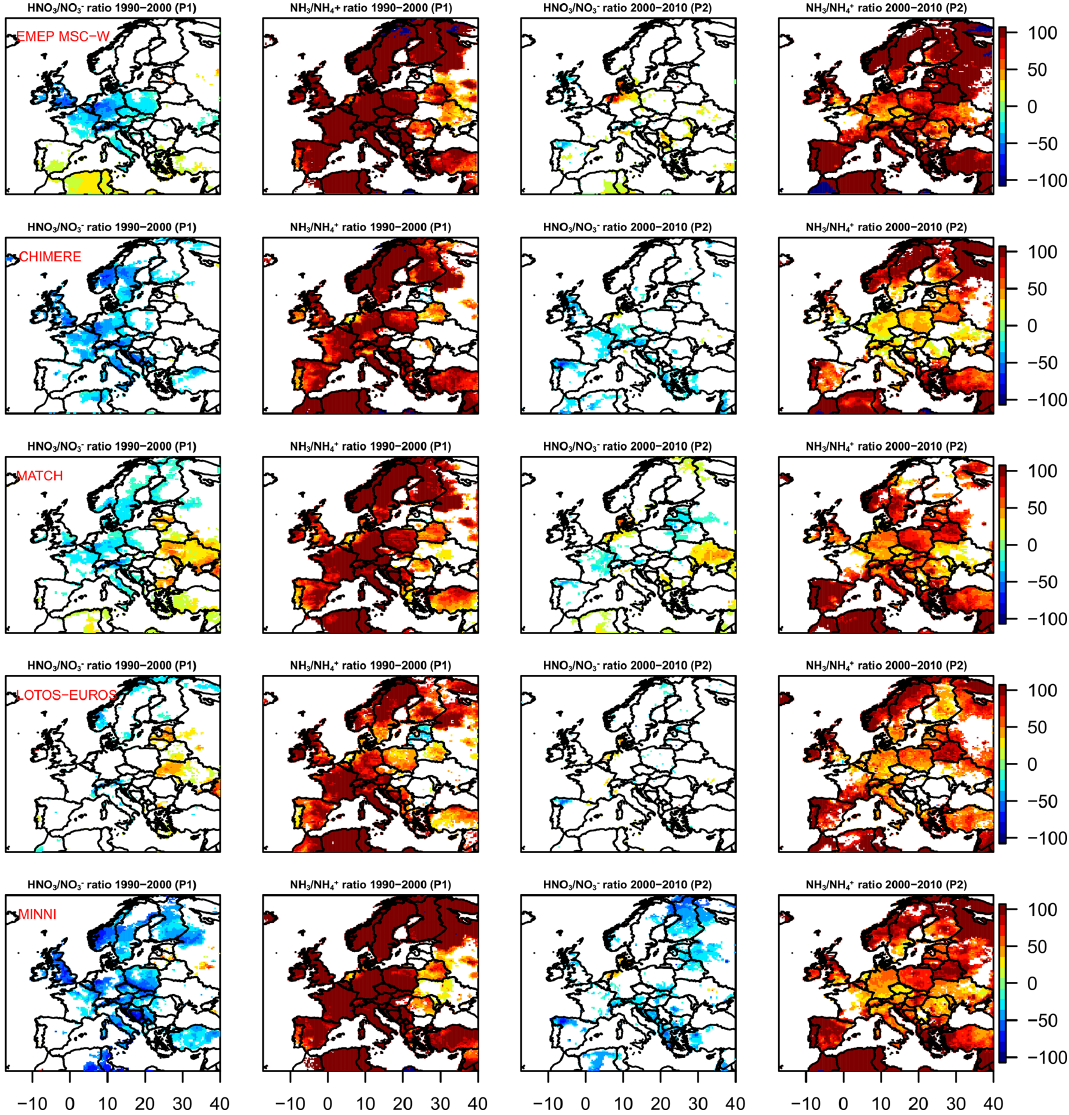
Figure 11. Modeled HNO 3 / NO − and NH 3 / NH + molar ratio relative trends over land for the P1 (1990–2000, first and second columns) and 3 4 P2 (2000–2010, third and fourth columns) periods as predicted by all the models (rows; from top to bottom: EMEP MSC-W, CHIMERE, MATCH, LOTOS-EUROS, MINNI). White areas indicate non-significant trends. The scale was saturated at 100% to facilitate the compre- hension of the